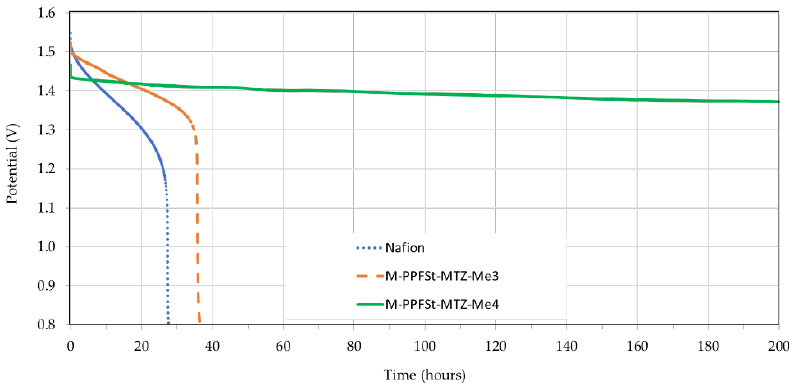
Figure 7. Open circuit voltage (OCV) of VRFBs with Nafion and blend membranes as a function of time.